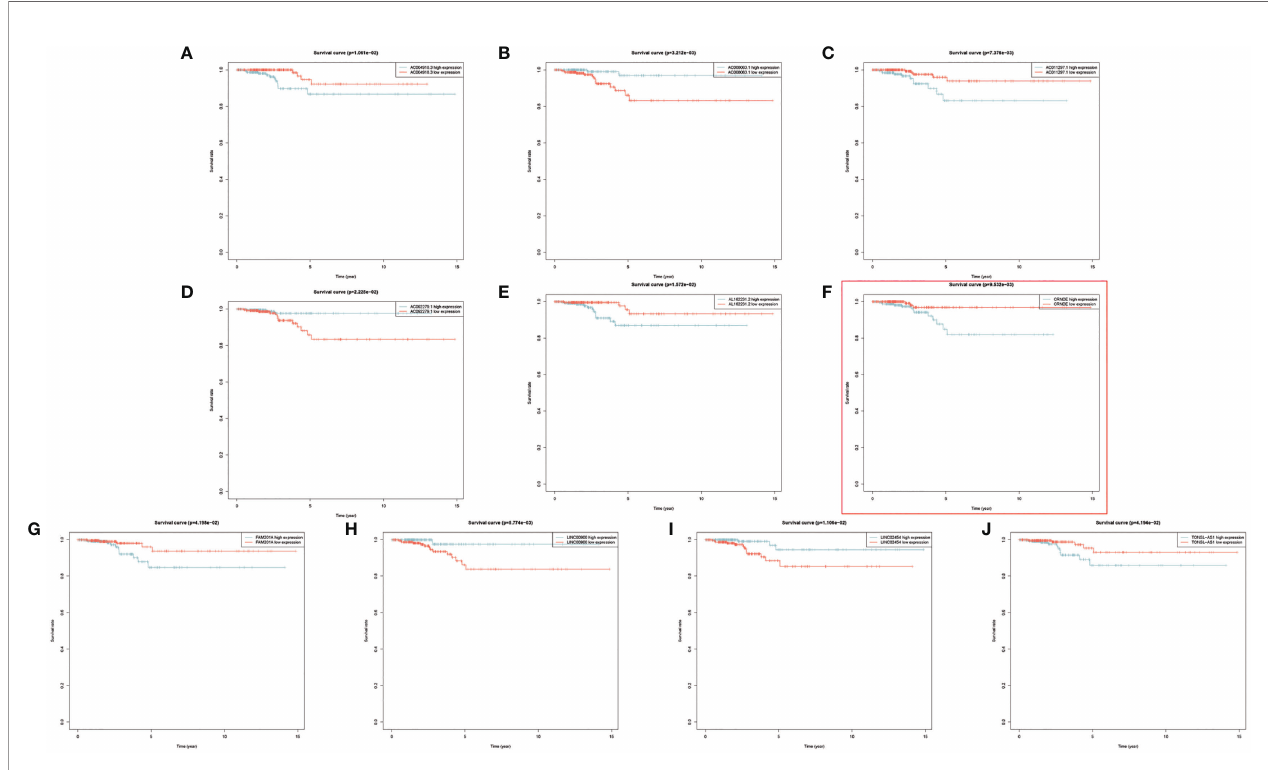
FIGURE 4 | (A – J) Kaplan – Meier survival analyses of 10 prognostic risk-related autophagy-related long noncoding RNA